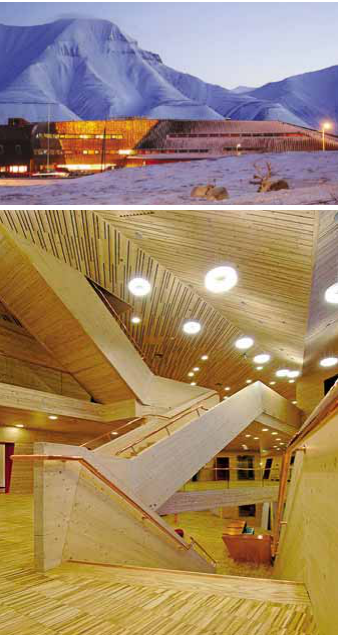
Fig. 12. Science center in Svalbard, Norway, archit. office “Jarmund/Vigsnaes AS”, 2005 (the exterior above and the interior below)